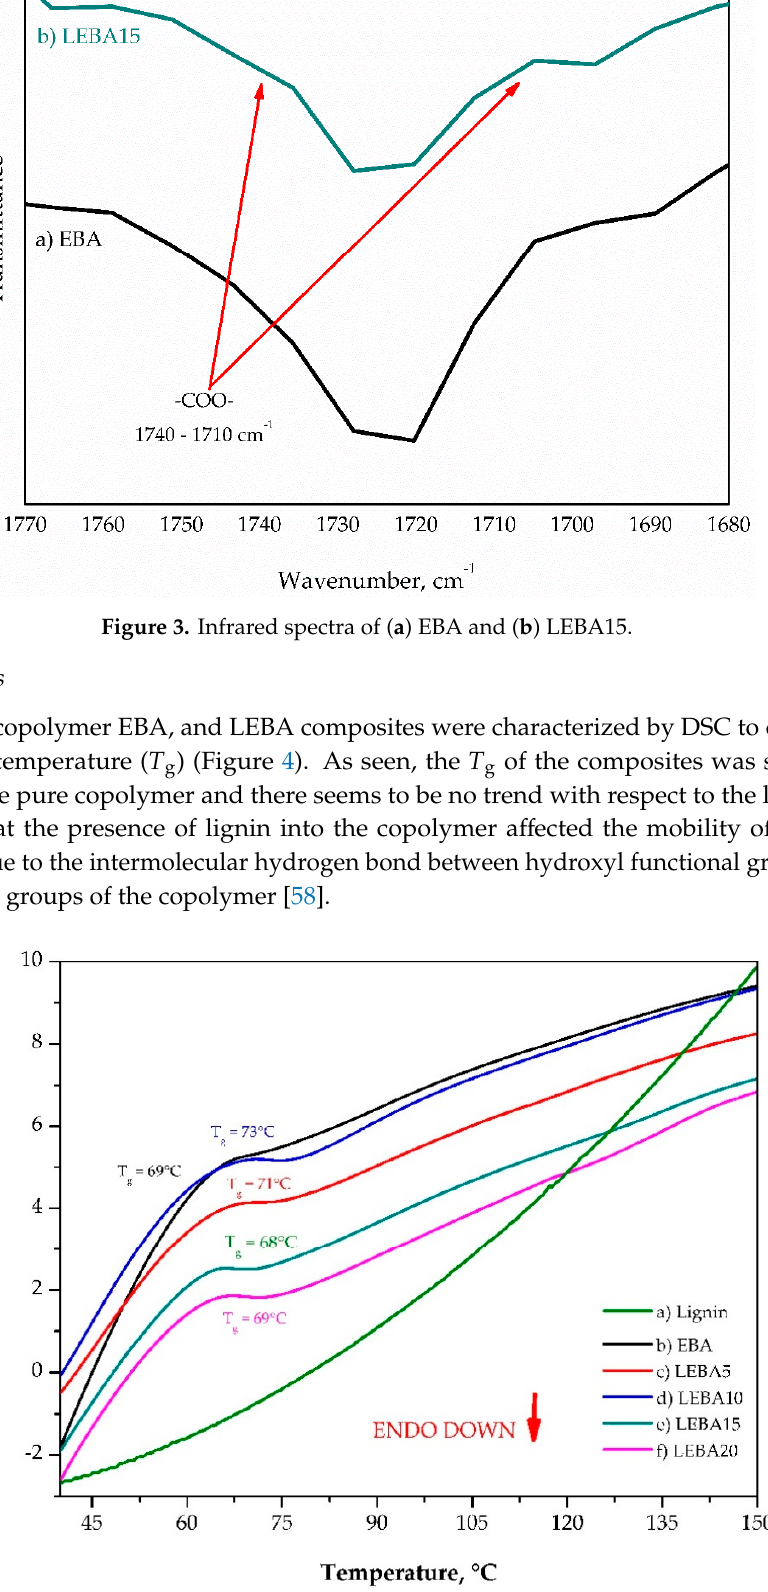
Figure 4. Differential scanning calorimeter (DSC) curves for ( a ) Lignin, ( b ) EBA, ( c ) LEBA5, ( d ) LEBA10, ( e ) LEBA15 and ( f ) LEBA20 composites.